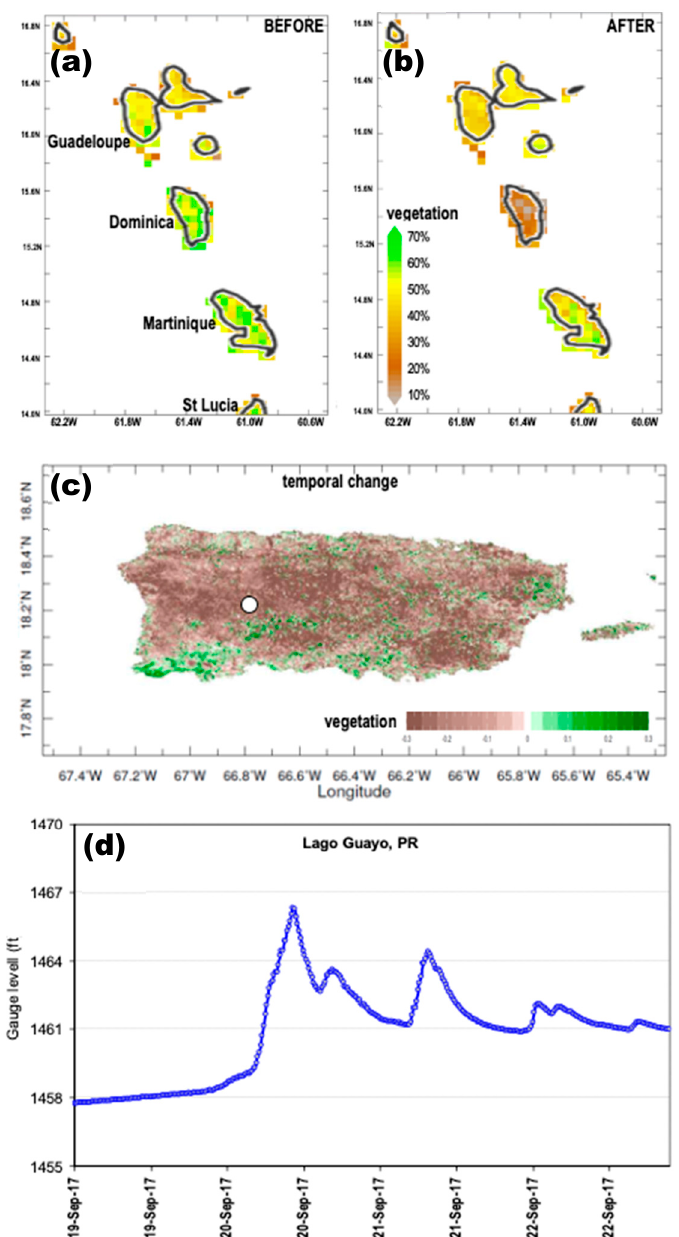
Figure 11. Comparison of satellite vegetation color fraction (NDVI) around Dominica: ( a ) Aug 2017 and ( b ) Oct 2017. ( c ) Same but NDVI change over PR: 1–15 Oct 2017 minus 1–15 September 2017. ( d ) USGS lake level record at Guayo, PR (dot in ( c )).